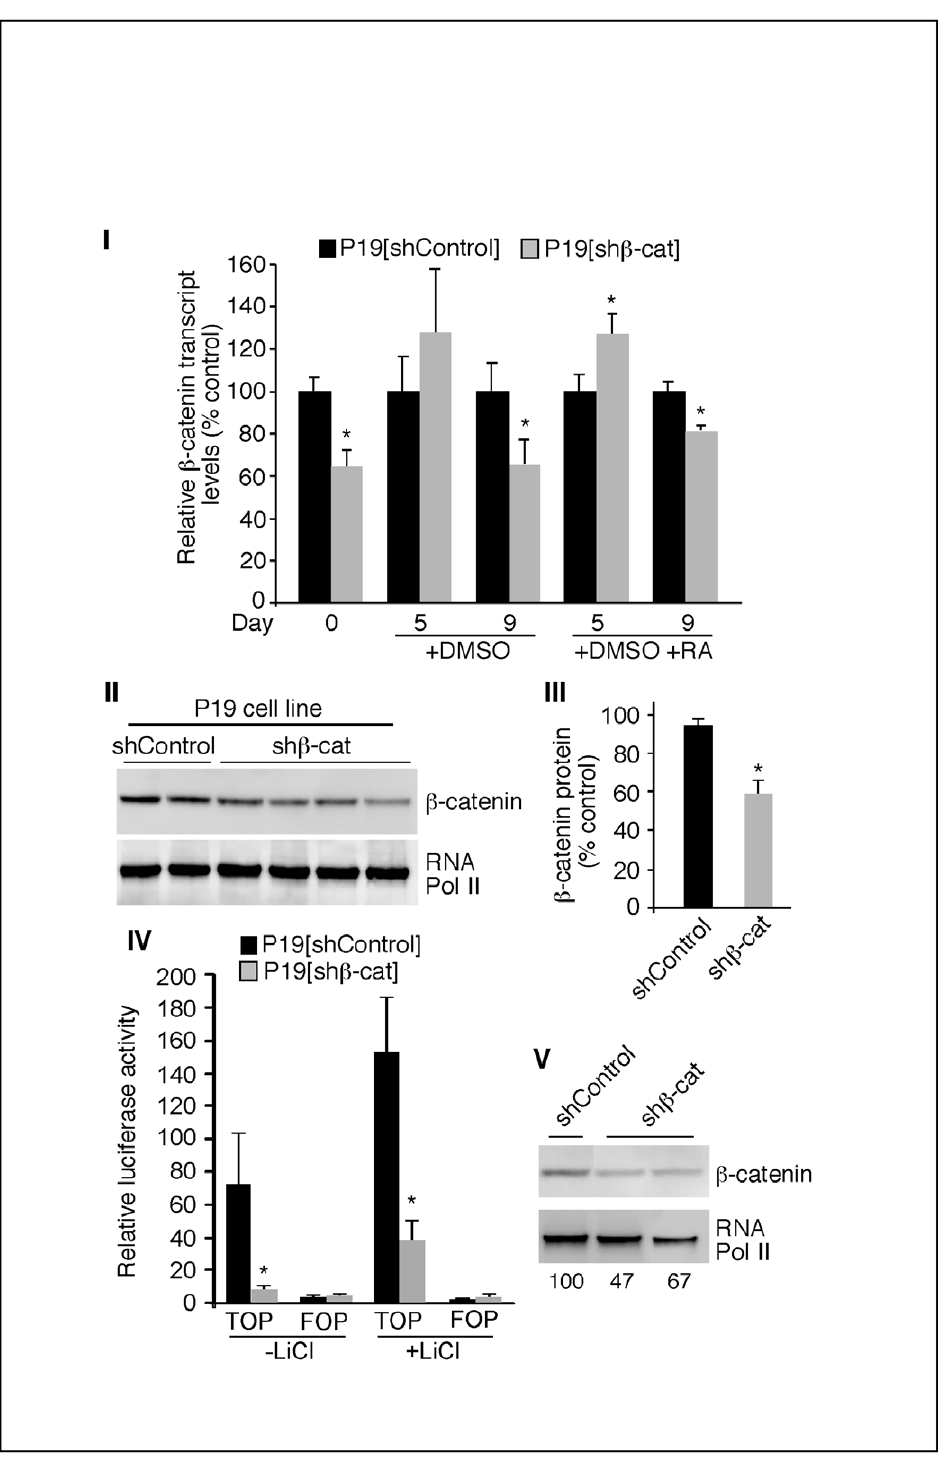
Figure 1. b -catenin transcriptional activity and protein levels were reduced in P19[sh b -cat] cells. Panel I: P19[shControl] and P19[sh b -cat] cells were differentiated in the presence of 1% DMSO with or without 3 nM RA. b -catenin transcript levels were determined by QPCR, which was performed from RNA harvested on the days indicated (n=12 for day 0, n=5 for day 5, n=4 for day 9). Changes in gene expression were normalized to b -actin and expressed as a percentage of P19[shControl] cells under each condition. Error bars represent 6 SEM. Student’s t-test was used to assess statistical significance, with *p # 0.05. Panel II&III : b -catenin protein was detected by western blot analysis using protein isolated from the nuclei of P19[shControl] and P19[sh b -cat] cells differentiated for five days with DMSO. Relative b -catenin protein levels were quantified by densitometry and normalized to RNA polymerase II protein levels (loading control). Error bars represent 6 SEM (n=4). Panel IV: P19[sh b -cat] and P19[shControl] cells were aggregated for 1 day in the presence or absence of 20 mM LiCl. Firefly luciferase activity was measured from cells co-transfected with either Super8XTOPFLASH (TOP) or Super8XFOPFLASH (FOP) and the Renilla control construct. All firefly luciferase activity was normalized to Renilla and